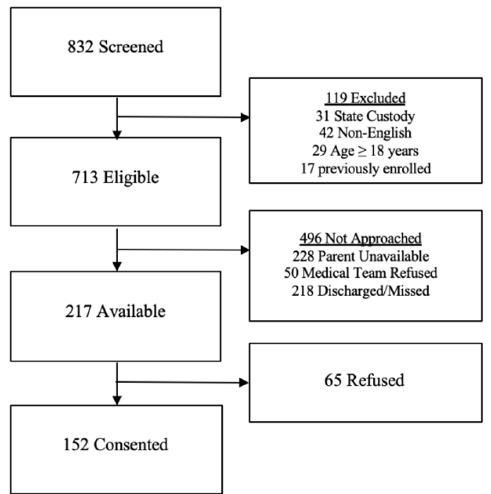
Figure 1. Study enrollment.